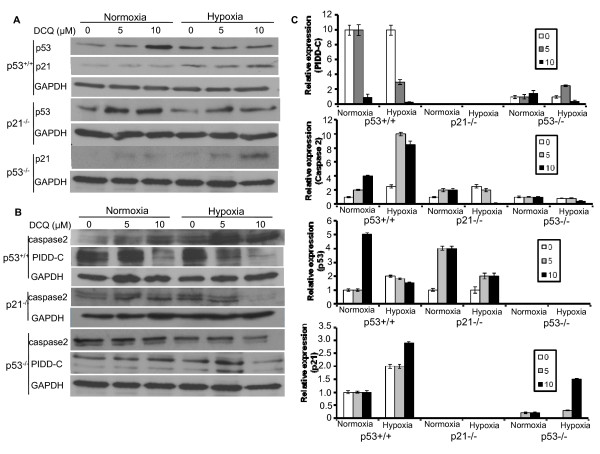
DCQ modulates the protein expression levels of key mediators of apoptosis and mitotic catastrophe. At 50% confluency, cells were treated with 5 or 10 μM DCQ for 6 hrs. Whole cell lysates were then immunoblotted with the different primary antibodies and probed with GAPDH to ensure equal loading. (A) p53 and p21 protein expression and (B) caspase-2 and PIDD-C protein expression in HCT116 cell lines in response to DCQ treatment under normoxic or hypoxic conditions. (C) Relative densitometry values of analyzed proteins are plotted. All values were normalized to GAPDH and calculated relative to the control cells cultured under normoxia. The experiment was repeated twice each in duplicates.